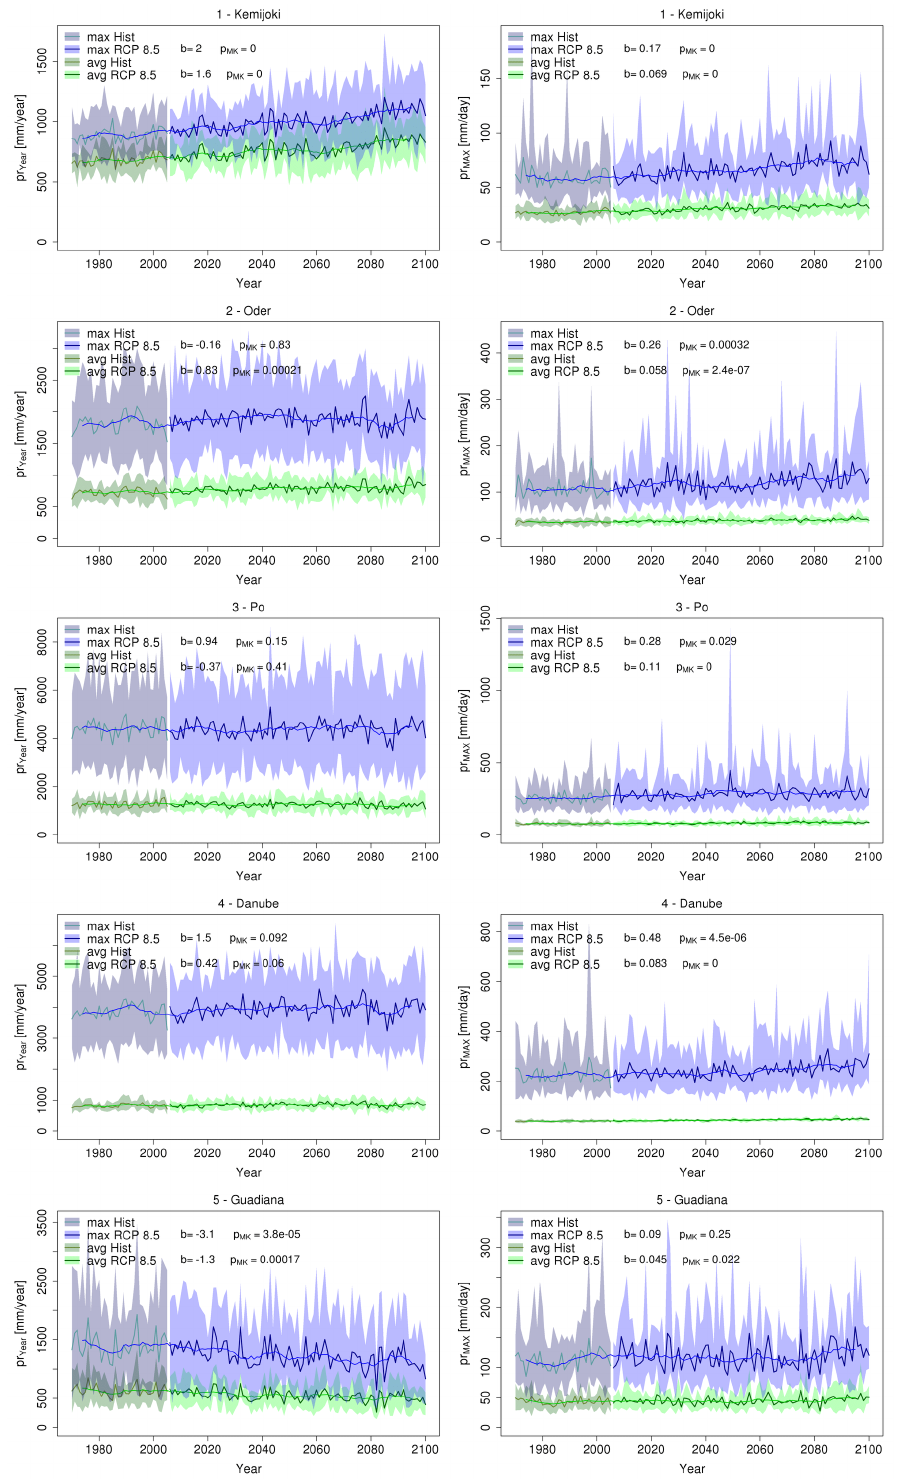
Figure 5. Annual precipitation (pr Year , left) and annual maximum daily precipitation (pr MAX , right) for five European river basins over time. Basin locations are shown in Fig. 1. Basin’s average (green shades) and maximum point value (blue shades) of the ensemble are shown together with the ensemble mean (thick lines) and the 10-year average (thin